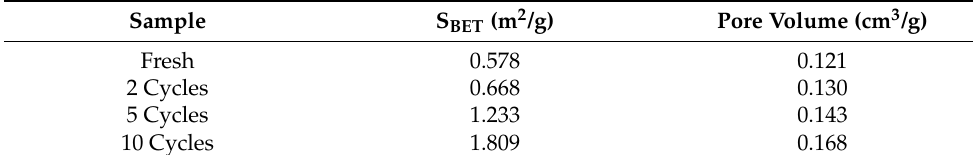
Table 5. The material texture of fresh and 10-cycle CuO/Ben oxygen carrier.